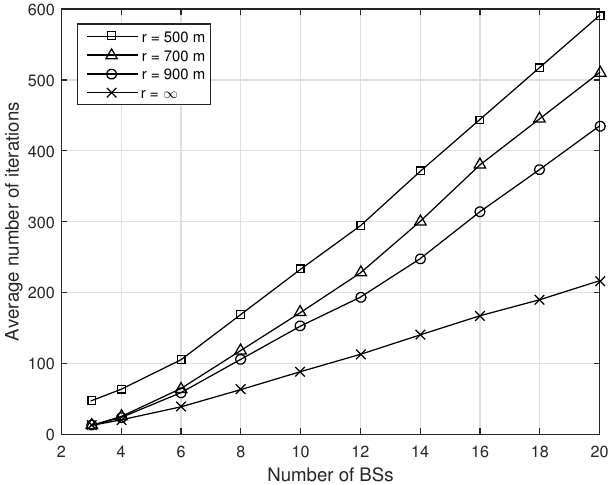
Figure 5. Number of iterations vs. number of BSs and overhearing range ( r ).